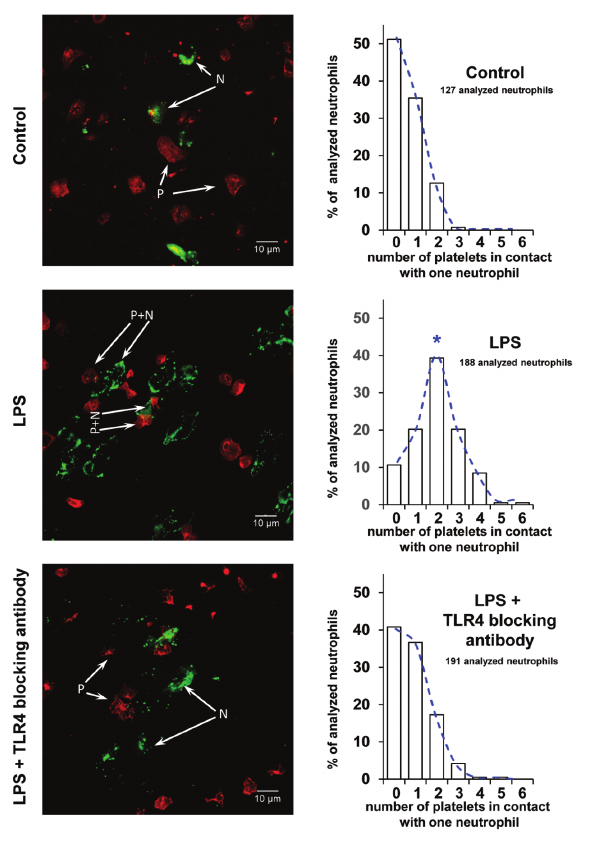
Fig. 1 LPS increases the frequency of platelet – neutrophil contacts of adhered neutrophils. Left side: the representative images show adherent neutrophils and platelets on poly-L-lysine-coated slides after incubation with neutrophil-platelet mixtures, stimulated with LPS ( “ LPS ” ), stimulated with LPS in the presence of a TLR4 blocking antibody ( “ LPS þ TLR4 blocking antibody ” ) or unstimulated ( “ Con- trol ” ). Adherent platelets were stained with an anti-CD41a antibody and a TRITC-conjugated secondary goat anti-mouse antibody (red). Adherent neutrophils were stained with a FITC-conjugatedanti-CD11b antibody (green). The slides were visualized with an inverted Nikon Eclipse Ti2 microscope using a 100 (cid:1) oil immersion objective and 1.5x zoom (14-bit digitalization). Right side: the quanti fi cation of neutro- phil-platelet complex formation is shown. In total (as the sum of the four experiments), 127 neutrophils were identi fi ed on the slides for “ control, ” 188 neutrophils for “ LPS ” and 191 neutrophils for “ LPS þ TLR4 blocking antibody. ” For each neutrophil, the number of platelets being in close contact to the neutrophils were assessed. The column diagrams show the distribution pattern of all counted neutrophils per setup according to the number of surrounding platelets (neutrophils in contact with 0 platelets, neutrophils in contact with 1 platelet, neutrophils in contact with 2 platelets, etc.). The distribution is given in percentage of the total number of analyzed neutrophils for “ Control, ” for “ LPS ” or for “ LPS þ TLR4 blocking antibody ” ; n ¼ 4; (cid:4) : p < 0.05; compared with “ Control ” and to “ LPS þ TLR4 blocking anti- body. ” LPS, lipopolysaccharides; TLR, toll-like receptor.